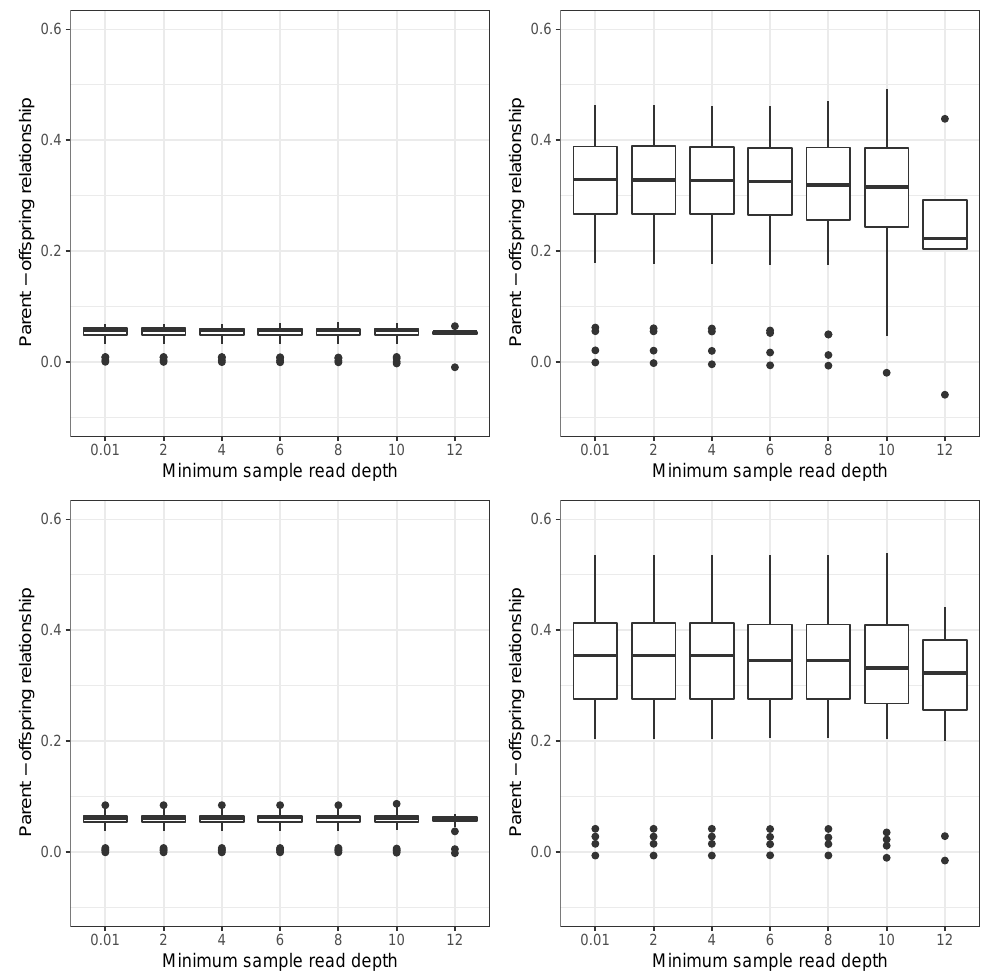
Figure 5. Parent-offspring relatedness distribution. Distribution of estimated relatedness for parent- offspring pairs under different minimum sample read depth thresholds in the whole population ( upper plots ) and only E.nitens population ( bottom plots ) using G1 [42] ( left plots ) and G5 [59] ( right plots ) relationship